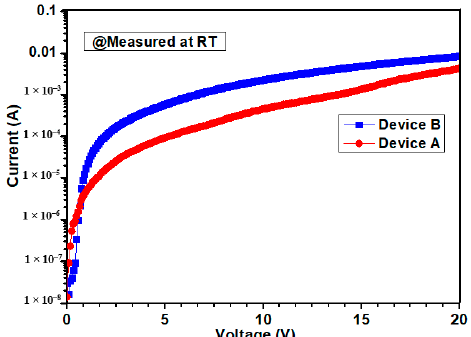
Figure 4. The I – V characteristics of device-A and device-A under the forward bias tested at room temperature.